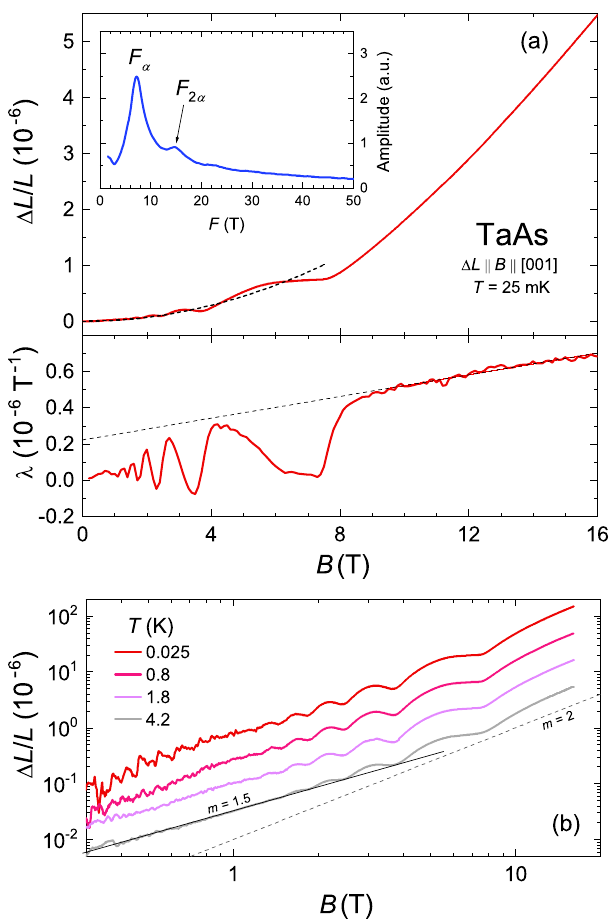
Fig. 2 Magnetostriction in the Weyl semimetal TaAs. a Top: Magnetic- fi eld dependence of the relative length change Δ L / L of TaAs (sample 1) measured along the [001] direction at 25 mK in the parallel con fi guration ( B ∥ Δ L ). Inset: FFT spectrum at T = 25 mK over a magnetic fi eld range of 1 – 8 T. The oscillatory magnetostriction was obtained by subtracting the background c b B 2 with c b = 1.79 × 10 − 8 T − 2 (dashed line in the main panel) from the experimental data. Bottom: Corresponding magnetostriction coef fi cient λ ≡ (1/ L ) dL / dB . The straight dashed line approximating λ ( B ) gives the intercept (2.28 × 10 − 7 T − 1 ) and has the slope (2.95 × 10 − 8 T − 2 ) which are close to the parameters b and 2 c h in the quadratic polynomial a + bB + c h B 2 (see the text and Table 1). b A log-log graph of the c -axis magnetostriction measured at different temperatures up to 4.2 K. Curves are offset for clarity. Note the slopes clearly distinct from the quadratic ( m = 2) behavior expected for B ≪ F i . The dashed and solid black straight lines correspond to Δ L / L ∝ B m .